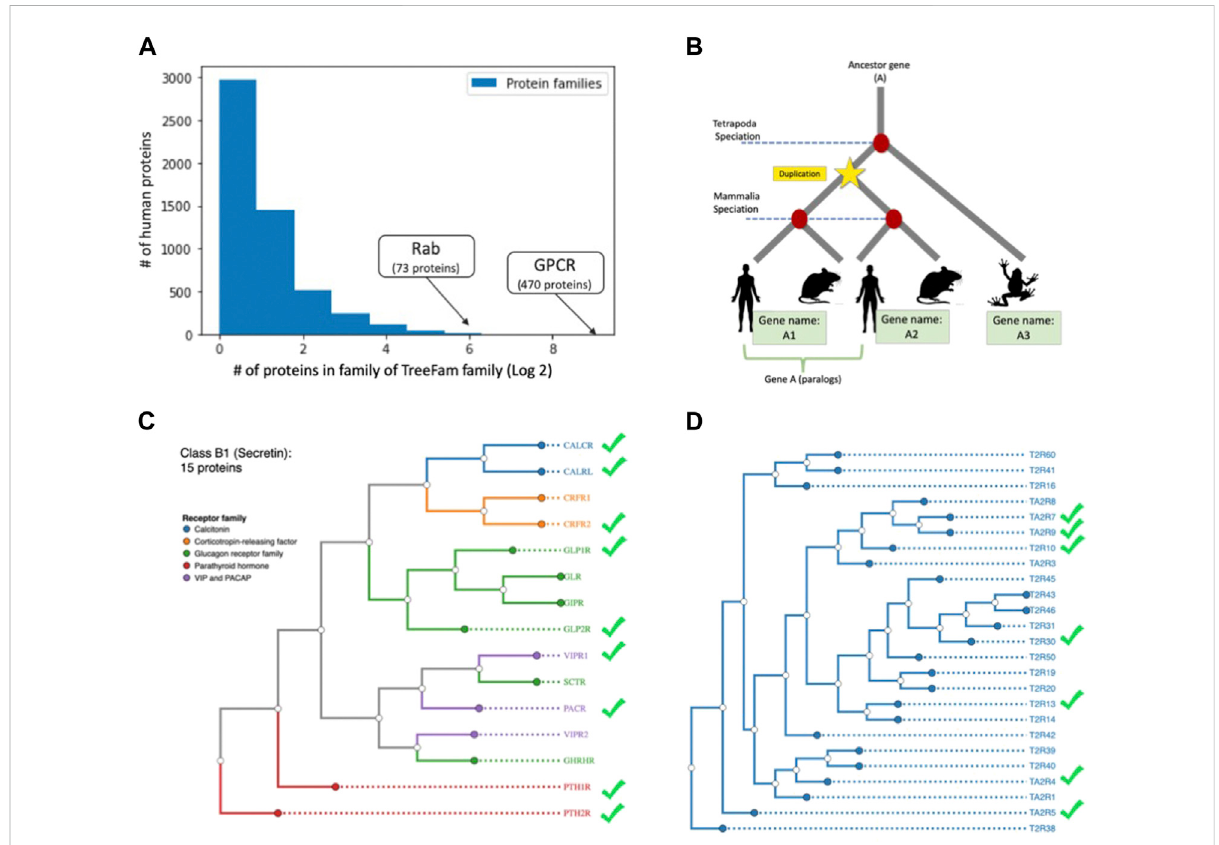
FIGURE 5 miRNA regulation of human paralogs. (A) The count of protein family members (log2 scale) with the number of proteins belonging to a family ( x -axis). The largest family with 470 members of G-protein coupled receptor (GPCR) is marked. (B) Schematic view of homologs and paralog of ancestor gene (A) . The duplication event prior to specialization de fi nes paralogs. (C) Phylograms of the GPCR Class B1 (Secretin) with 15 gene paralogswithnineregulatedbymiRNAs.Thereceptorgroupsarecolorcoded(e.g.,Glucagonreceptor). (D) MembersofGPCRofClassT(Taste 2) with 25 proteins, among them only seven proteins were predicted as miRNA regulated (marked in green symbol) the rest of the proteins were predicted as not under miRNA regulation. The source of proteins in C and D and their annotation is according to GPCRdb (Pandy-Szekeres et al., 2022). The trees are generated from whole sequence phylogenetic trees within each GPCR class using unweighted pair group method with arithmetic mean (UPGMA, 10